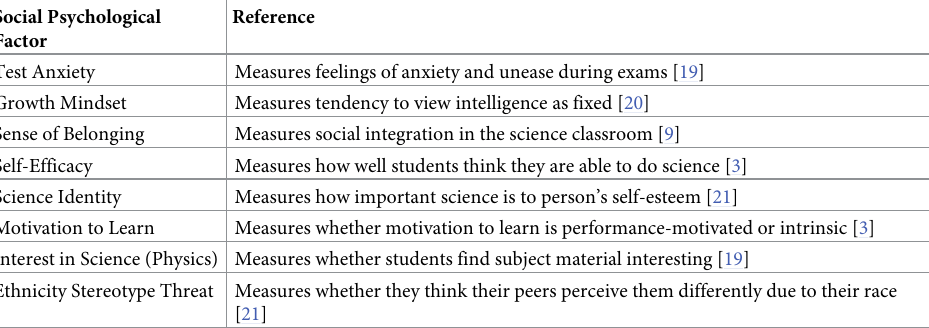
Table 1. List of social-psychological constructs probed by the survey and relevant